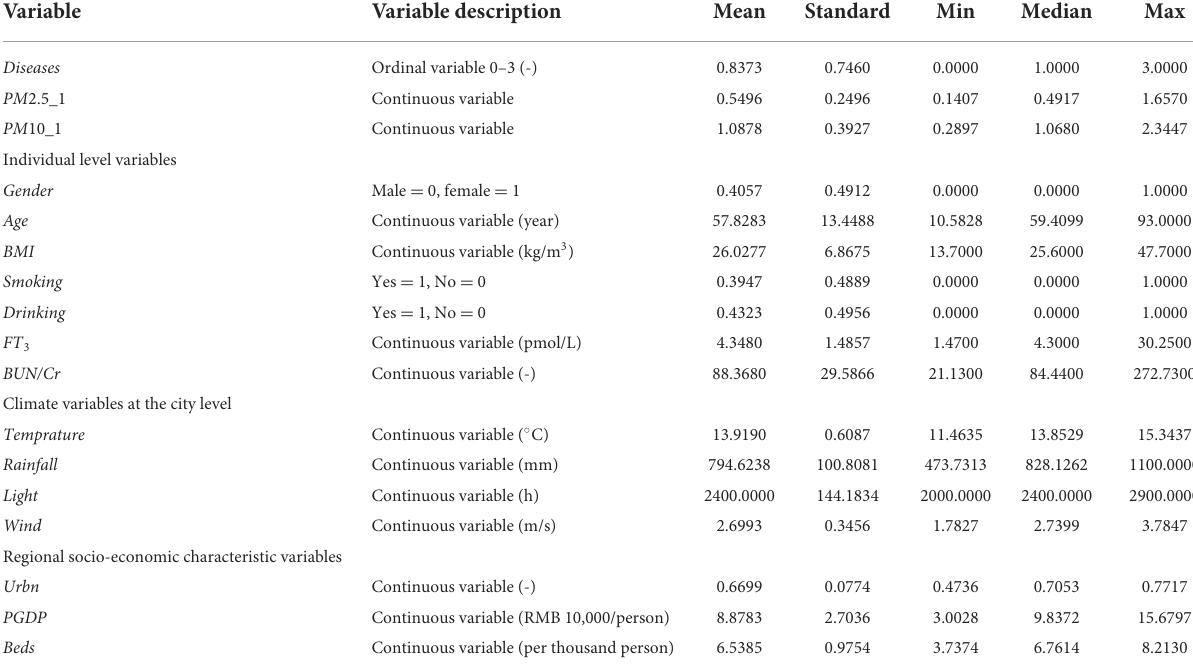
TABLE 1 Descriptive statistics ( n =